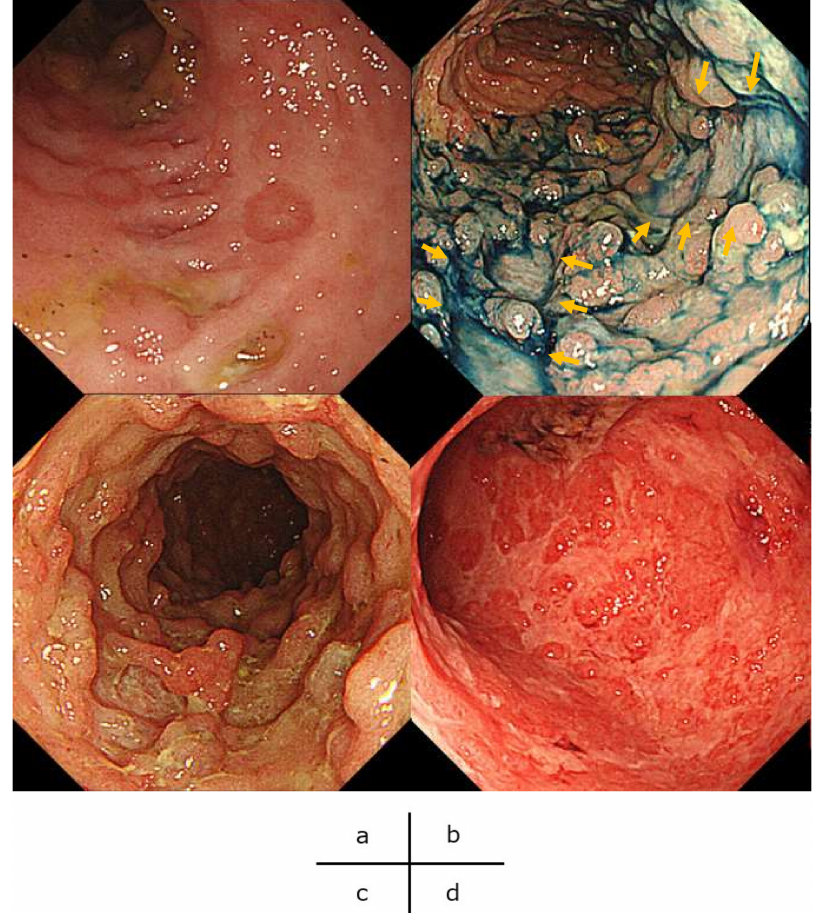
Figure 2. Characteristic endoscopic findings of ulcerative colitis complicated by human cytomegalovirus infection. ( a ) Punched-out ulcers: the round shape of ulcerations with clear demarcation. ( b ) Longitudinal ulcers: ulcerations running along the lumen of the colon (arrows). ( c ) Di ff use mucosal defect: many mucosal defects with surrounding reddish and erythematous mucosa. ( d ) Geographic ulcers: shallow and widespread mucosal defects with unclear